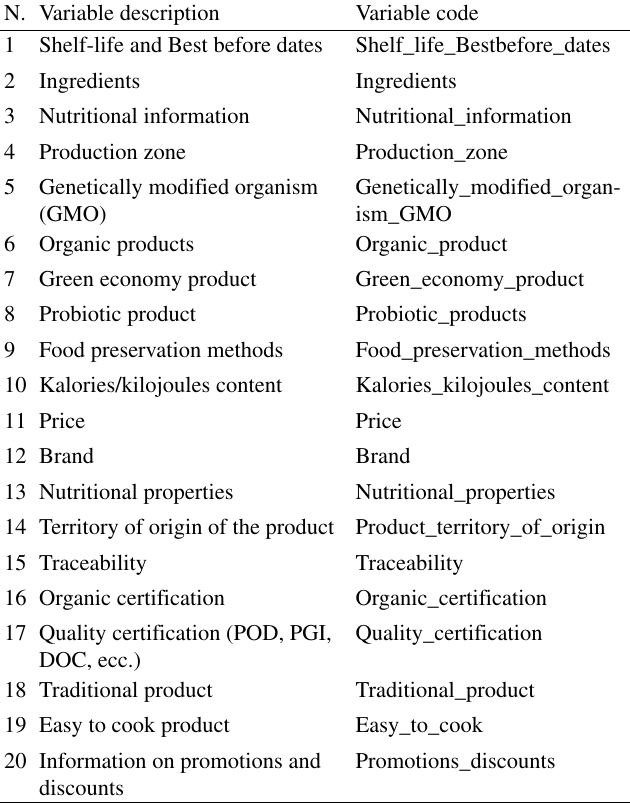
Table 3 - Variable description and Variable